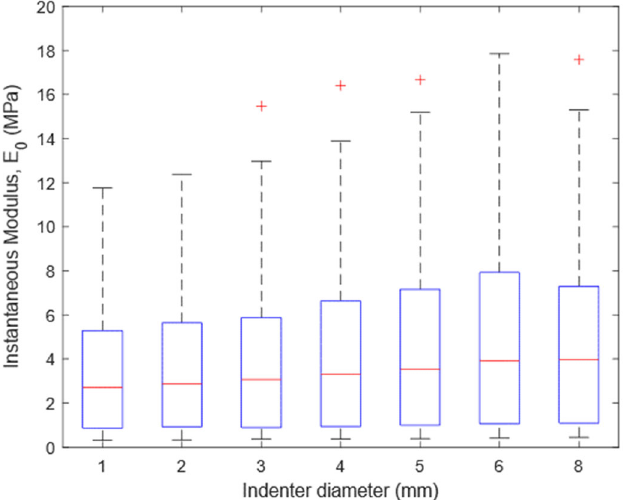
Figure 4. Box plot of E 0 values determined with indenters having different diameters, achieved by evaluating 126 points over the articular surface of ten bovine knees.